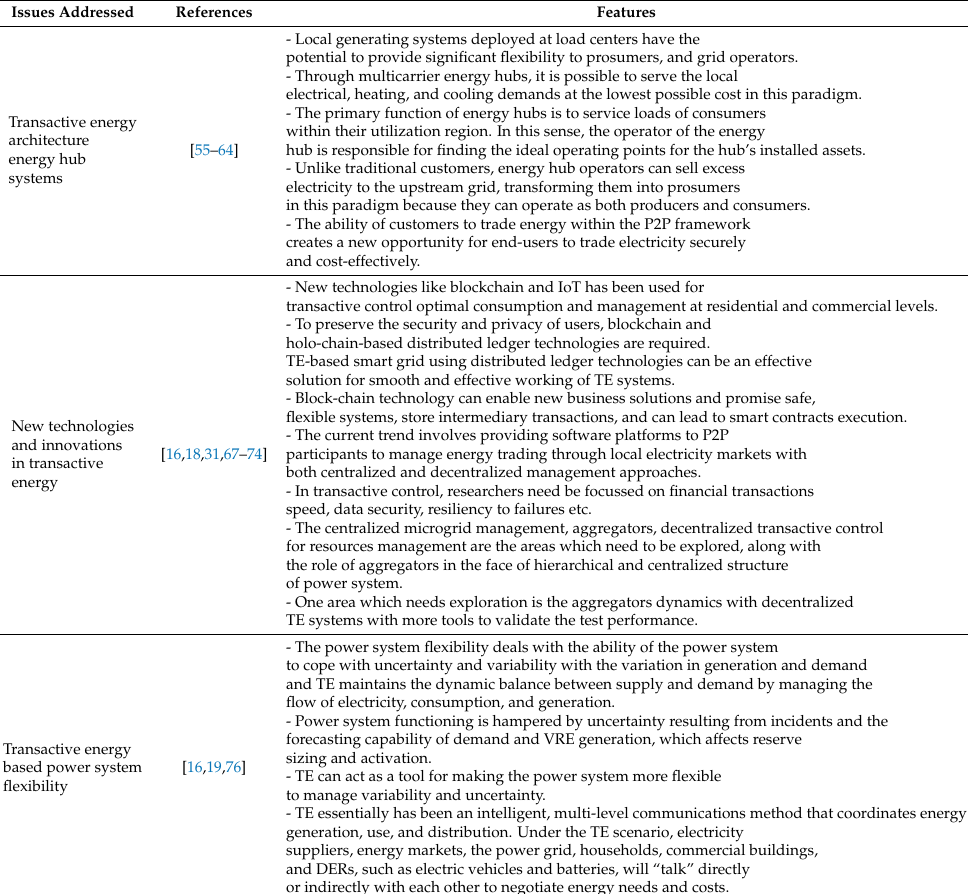
Table 3. Various issues addressed and their salient